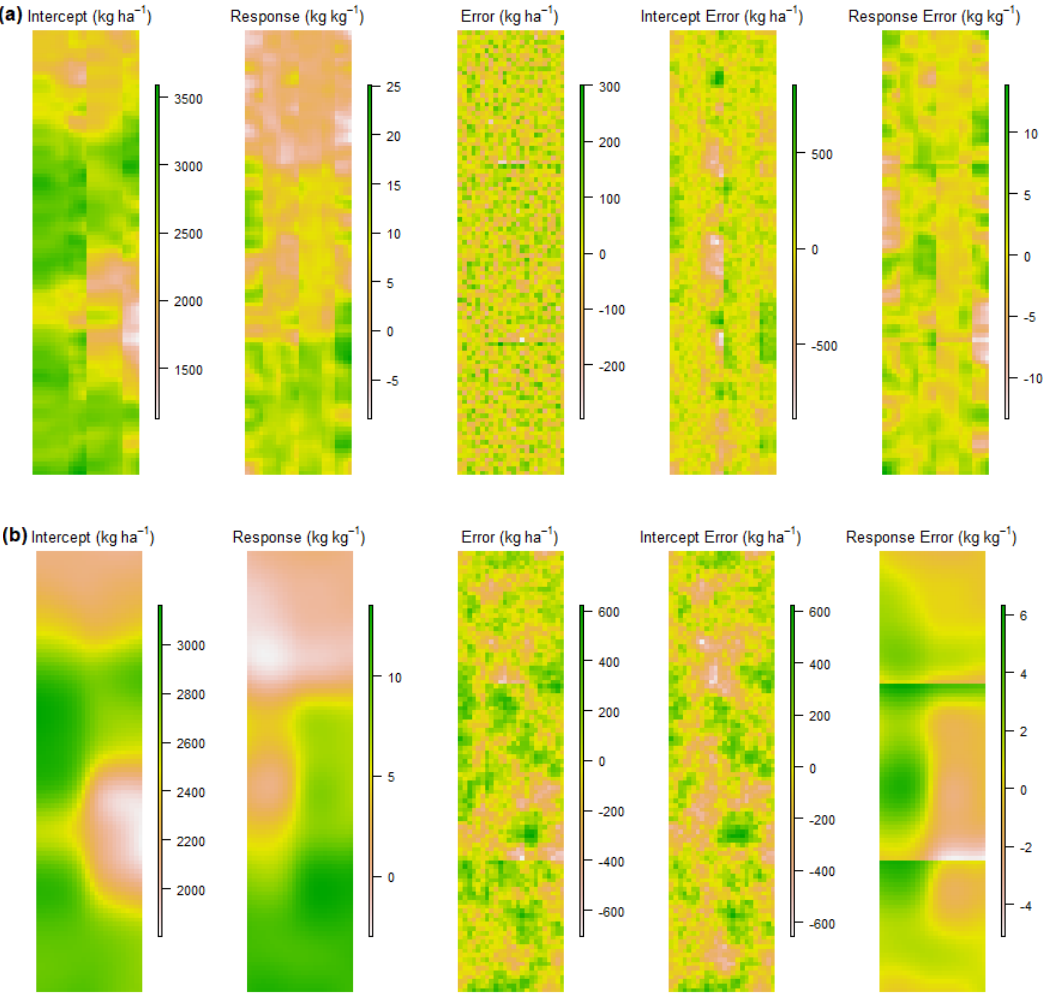
Figure 7. Results for data simulated with local linear response by zones using bandwidth selection by ( a ) minimal AICc and ( b ) based on experimental design.